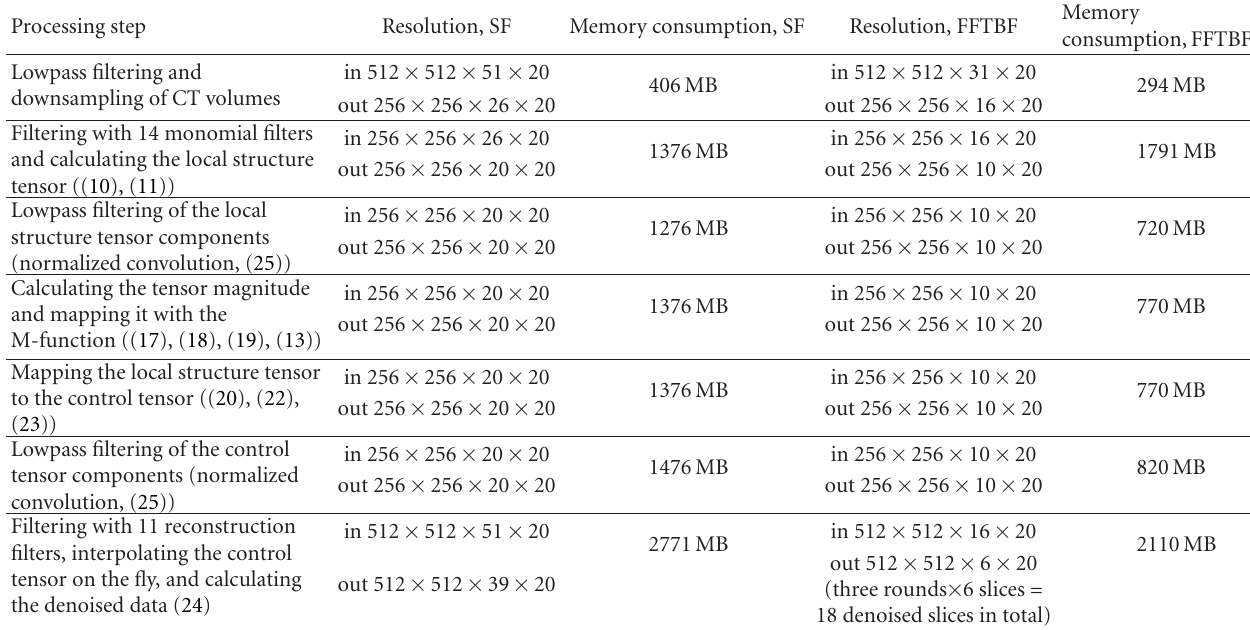
Table 2: The table shows the in and out data resolution, the used equations and the memory consumption for all the processing steps for spatial filtering (SF) and FFT-based filtering (FFTBF). Note that the driver for the GPU is stored in the global memory, and it normally requires 100–200